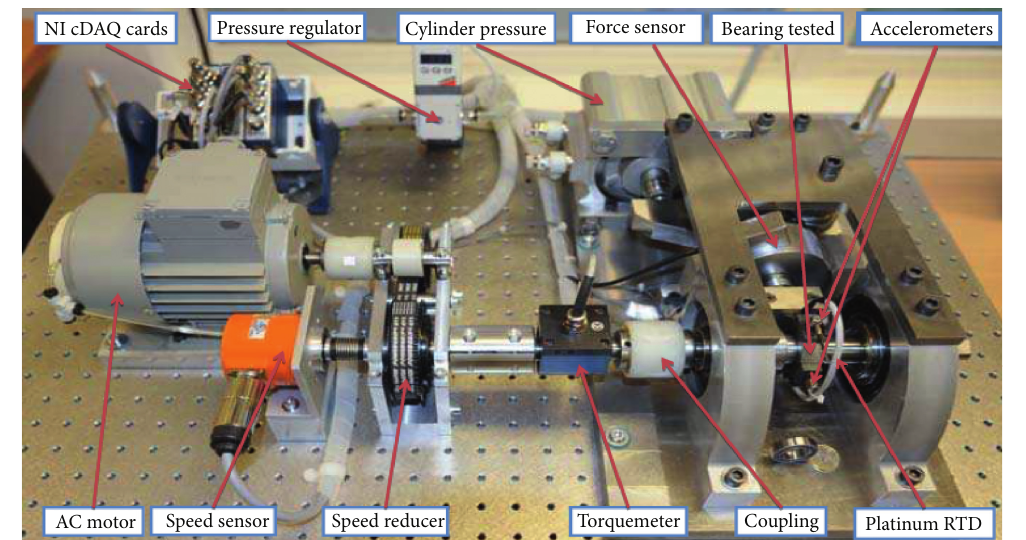
Figure 5: The experimental data acquisition